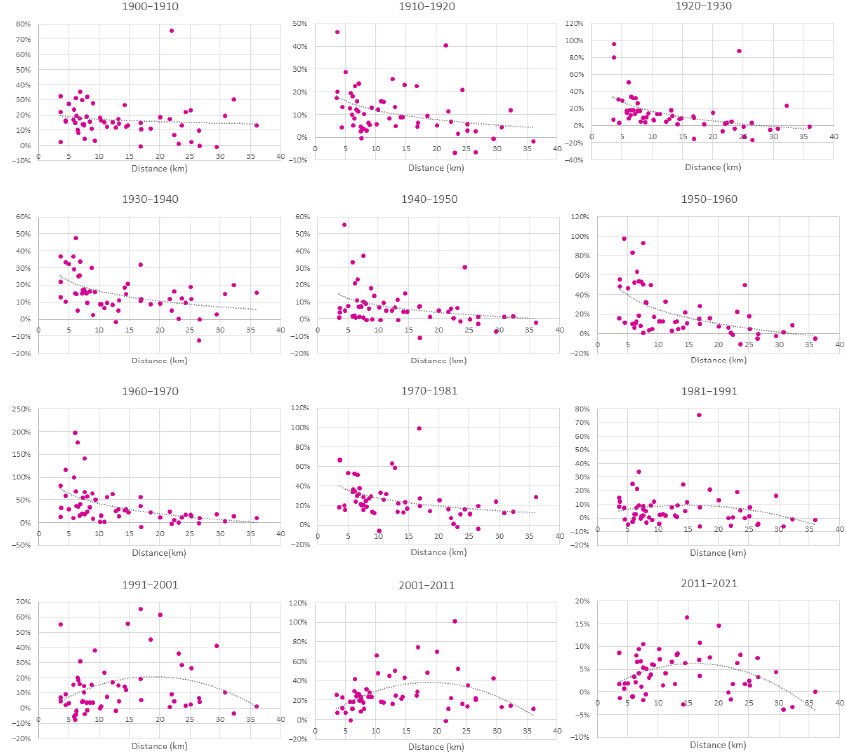
Figure 8 Figure 8. Relationship between population increase and distance to the centre in municipalities with a rail transport